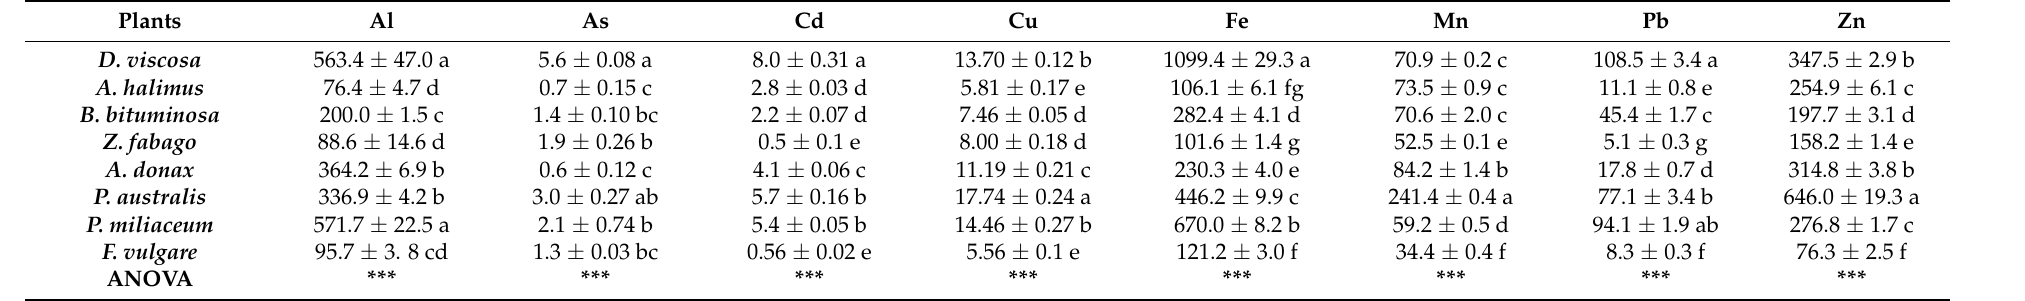
Table 1. Trace element concentrations (mg kg − 1 ) in the aerial part of the plants used in the experiment (average ± se; n = 2). Plants